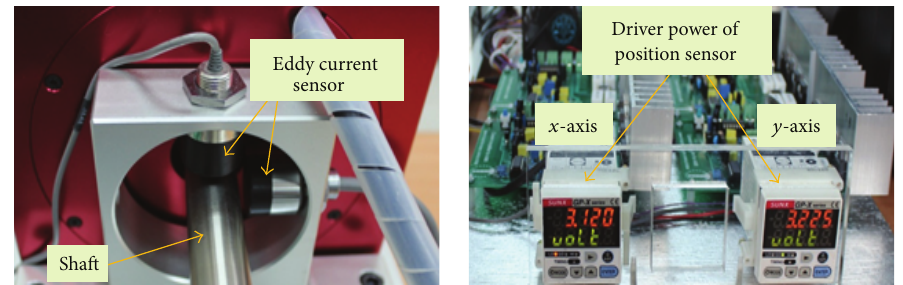
Figure 14: Eddy sensor and driver